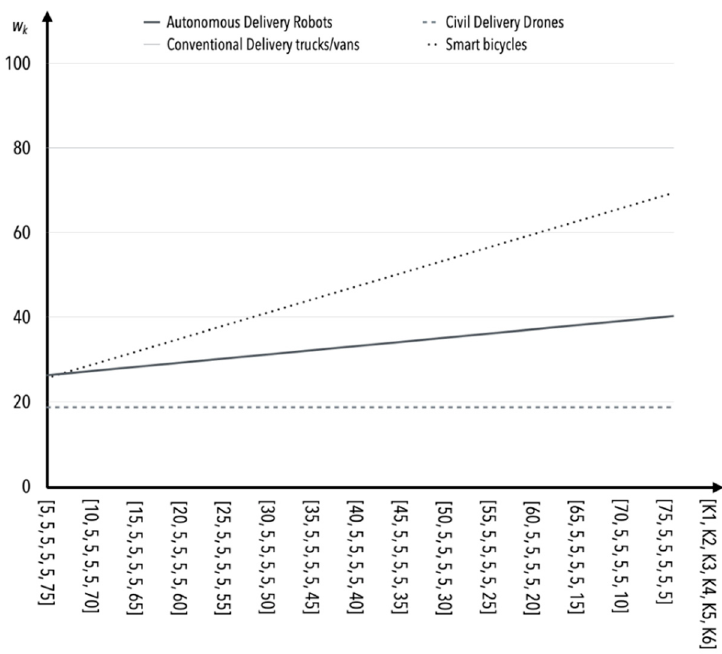
Figure 4. The influence of weight value changes for criterion K 3 on criteria K 1 , K 2, K 4, K 5 (in the case of S1).